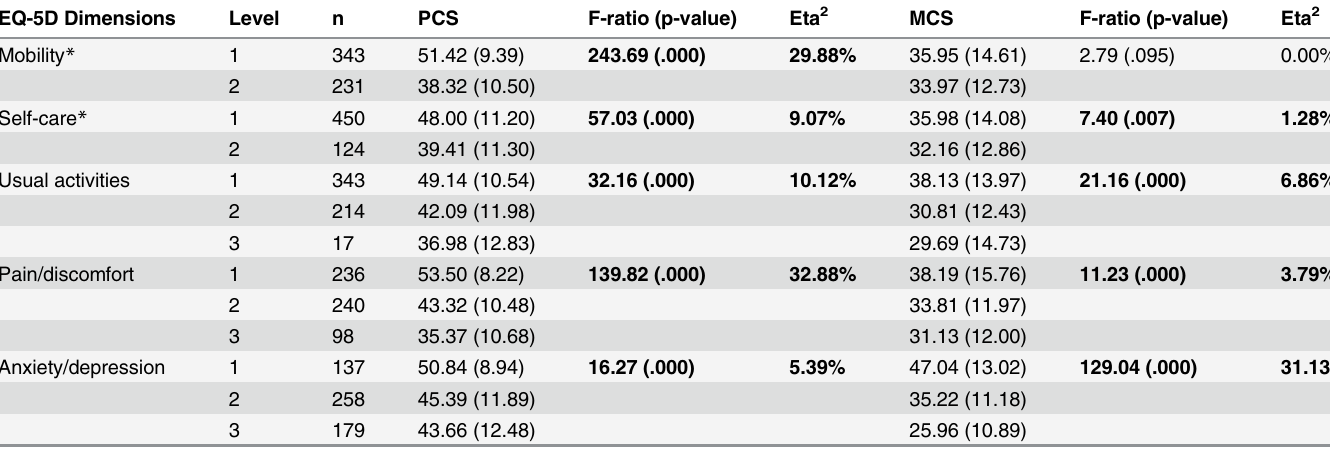
Table 5. Mean (SD) SF-12v2 Composite Scores by EQ-5D Dimensions, and ANOVA